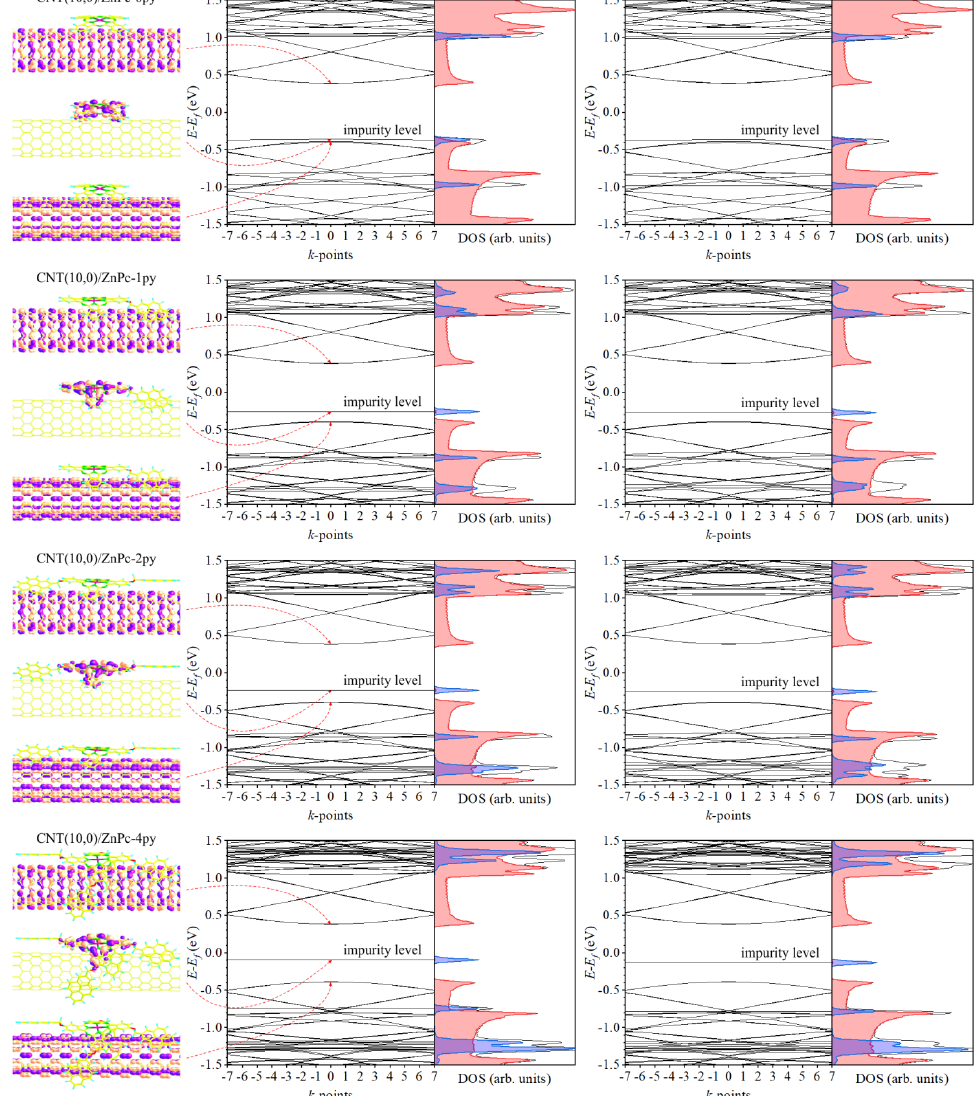
Figure 3. Band structure and densities of states of CNT(10,0)/ZnPc- x py ( center panels) and CNT(10,0)/ZnPc- x py/4NH 3 ( right panels); electron wave functions of the conduction band bottom, the impurity band, and the valence band top of the hybrids without ammonia molecules ( left pan- els). In the case of densities of states, the black line is the total DOS, and the red and blue peaks are the partial DOS of the CNT(10,0) and ZnPc- x py atoms separately. With an increase in the number of oxypyrene substituents, this ratio increases (Table 1). This means that the addition of ammonia leads to a greater decrease in the population of the conduction band. Thus, at room temperature, in the case of CNT(10,0)/ZnPc-0py, the population decreases by 1.1, while in the case of CNT(10,0)/ZnPc-4py, it decreases by